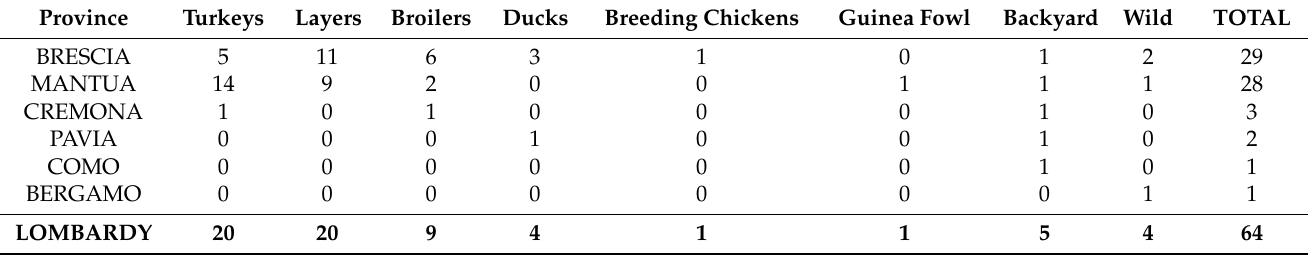
Table 1. Outbreaks detected during the HPAI 2021–2022 epidemic in the Lombardy